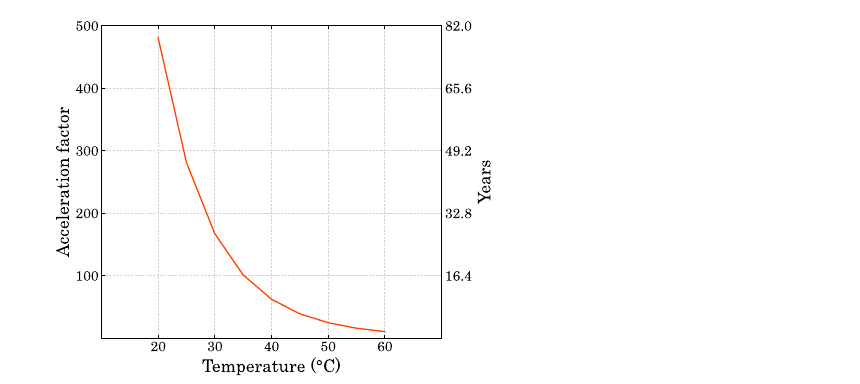
Figure 3. Acceleration factor and ageing estimation per operation